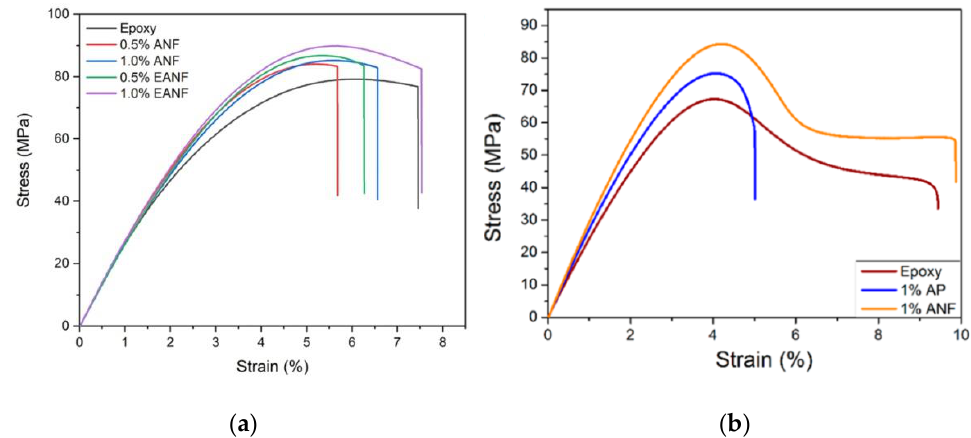
Figure 13. ( a ) strain improvement by various amounts of ANF (adapted with permission from Ref. [98], 2020, copyright Elsevier Ltd.) and ( b ) enhancement of attainable strains of ANF versus AP Ref. [98], Copyright 2020 Elsevier Ltd.) and ( b ) enhancement of attainable strains of ANF versus AP (adapted with permission from Ref. [100], 2017, copyright American Chemical Society). (adapted with permission from Ref. [100], Copyright 2017 American Chemical